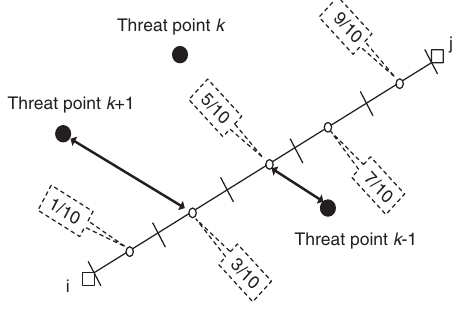
Figure 2. Calculation for Threat